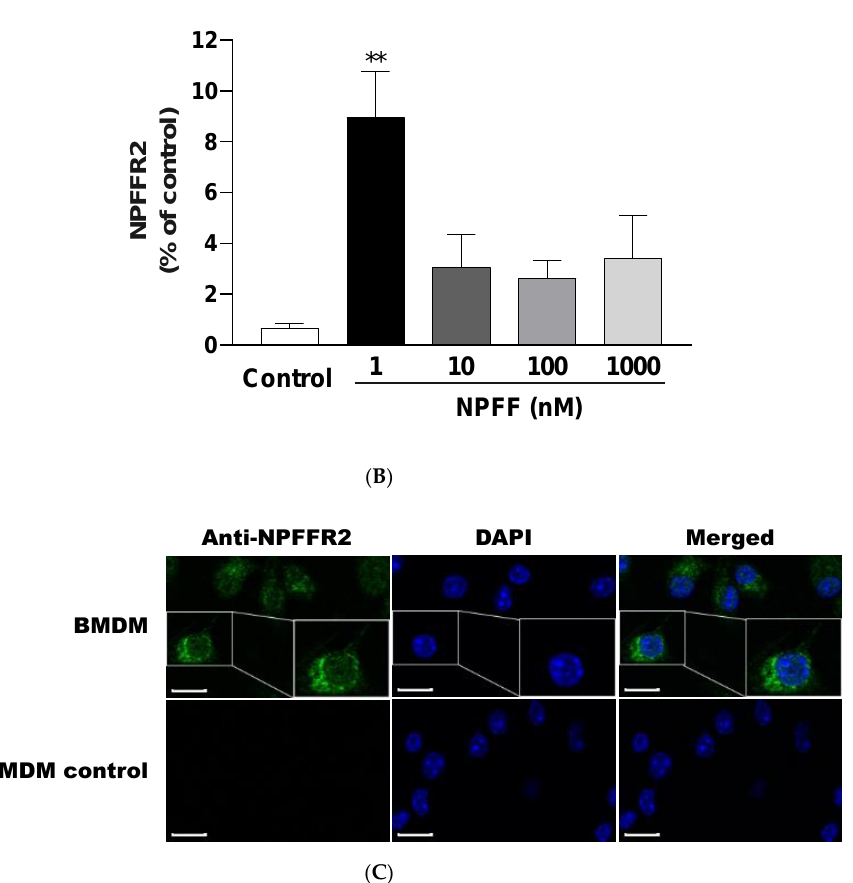
Figure 10. The expression of NPFFR2 protein in BMDMs was examined by Western blot and immunofluorescence staining. ( A ) BMDMs were incubated with NPFF (1 nM) for 18 h, followed by immunoblot analysis of NPFFR2 protein level (n = 3). ( B ) quantification of the bands in ( A ). ( C ) The expression of NPFFR2 in BMDMs was examined by immunofluorescence staining. NPFFR2 stained with anti-NPFFR2 antibody showed green, and the nucleus stained with DAPI showed blue. Scale bar, 10 µ m. The data were demonstrated as the means ± S.E.M. *, significantly different from the control group; * p < 0.05; ** p < 0.01. Statistical significance analysis was conducted using the one-way ANOVA followed by the Tukey post hoc tests